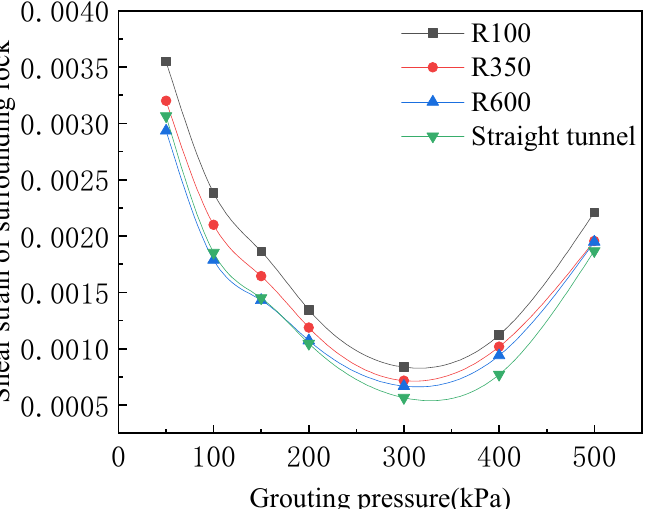
Figure 14. Variation curve of maximum shear strain of surrounding rock with the grouting pressure. It can be seen from Figure 13 that the variation trend of the maximum shear stress of the surrounding rock with the grouting pressure of the four tunnels is similar, that is, when the grouting pressure is less than 400 kPa, the maximum shear stress of the surrounding rock decreases, and when it is greater than 400 kPa, the maximum shear stress of the surrounding rock decreases. Then, it increases slowly, because the larger grouting pressure squeezes the surrounding rock or even destroys the surrounding rock. When the grouting pressure is 200 kPa, and the maximum shear stress of the surrounding rock with a curve radius of 100 m, 350 m, 600 m, and the straight tunnel is 202.6 kPa, 180.9 kPa, 176.6 kPa, and 169.6 kPa, respectively. Compared with the maximum shear stress of the surrounding rock with the straight tunnel, the maximum shear stress of the surrounding rock corresponding to the curve radius of 100 m, 350 m, and 600 m increased by 19.46%, 6.66%, and 4.13%, respectively. This is because the smaller the curve radius is, the more uneven the force on the surrounding rock is, which leads to greater stress on the surrounding rock. It can be seen that under the same conditions, the smaller the curve radius is, the easier the surrounding rock is to be unstable and